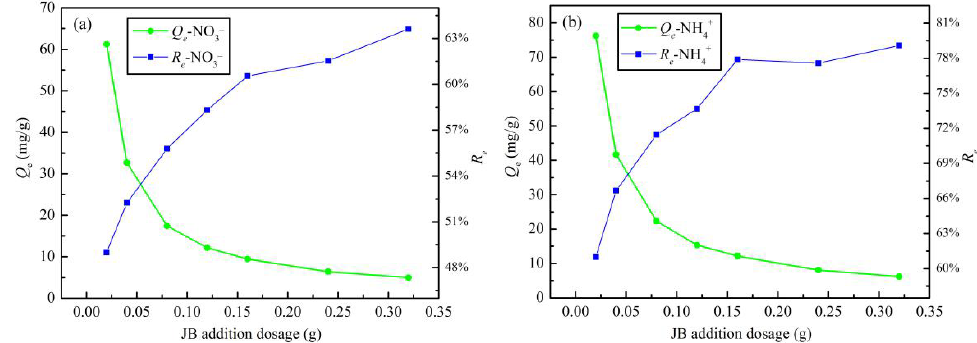
Figure 8. Effects of addition dosage on JB adsorption capacity and removal rate. ( a ) for NO 3 − , ( b ) for NH 4 + .